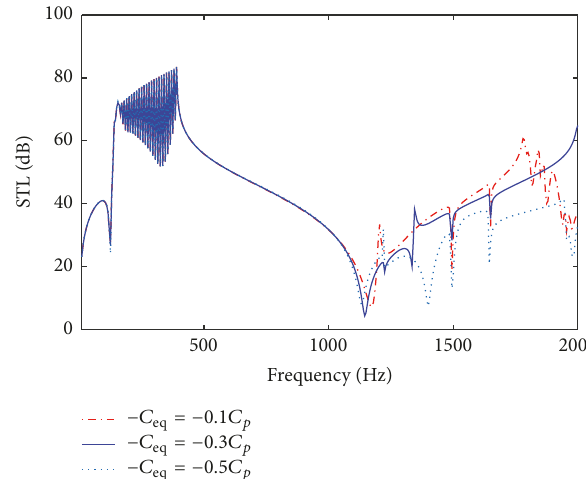
Figure 15: STLs of the research structure under the condition of having selecting negative